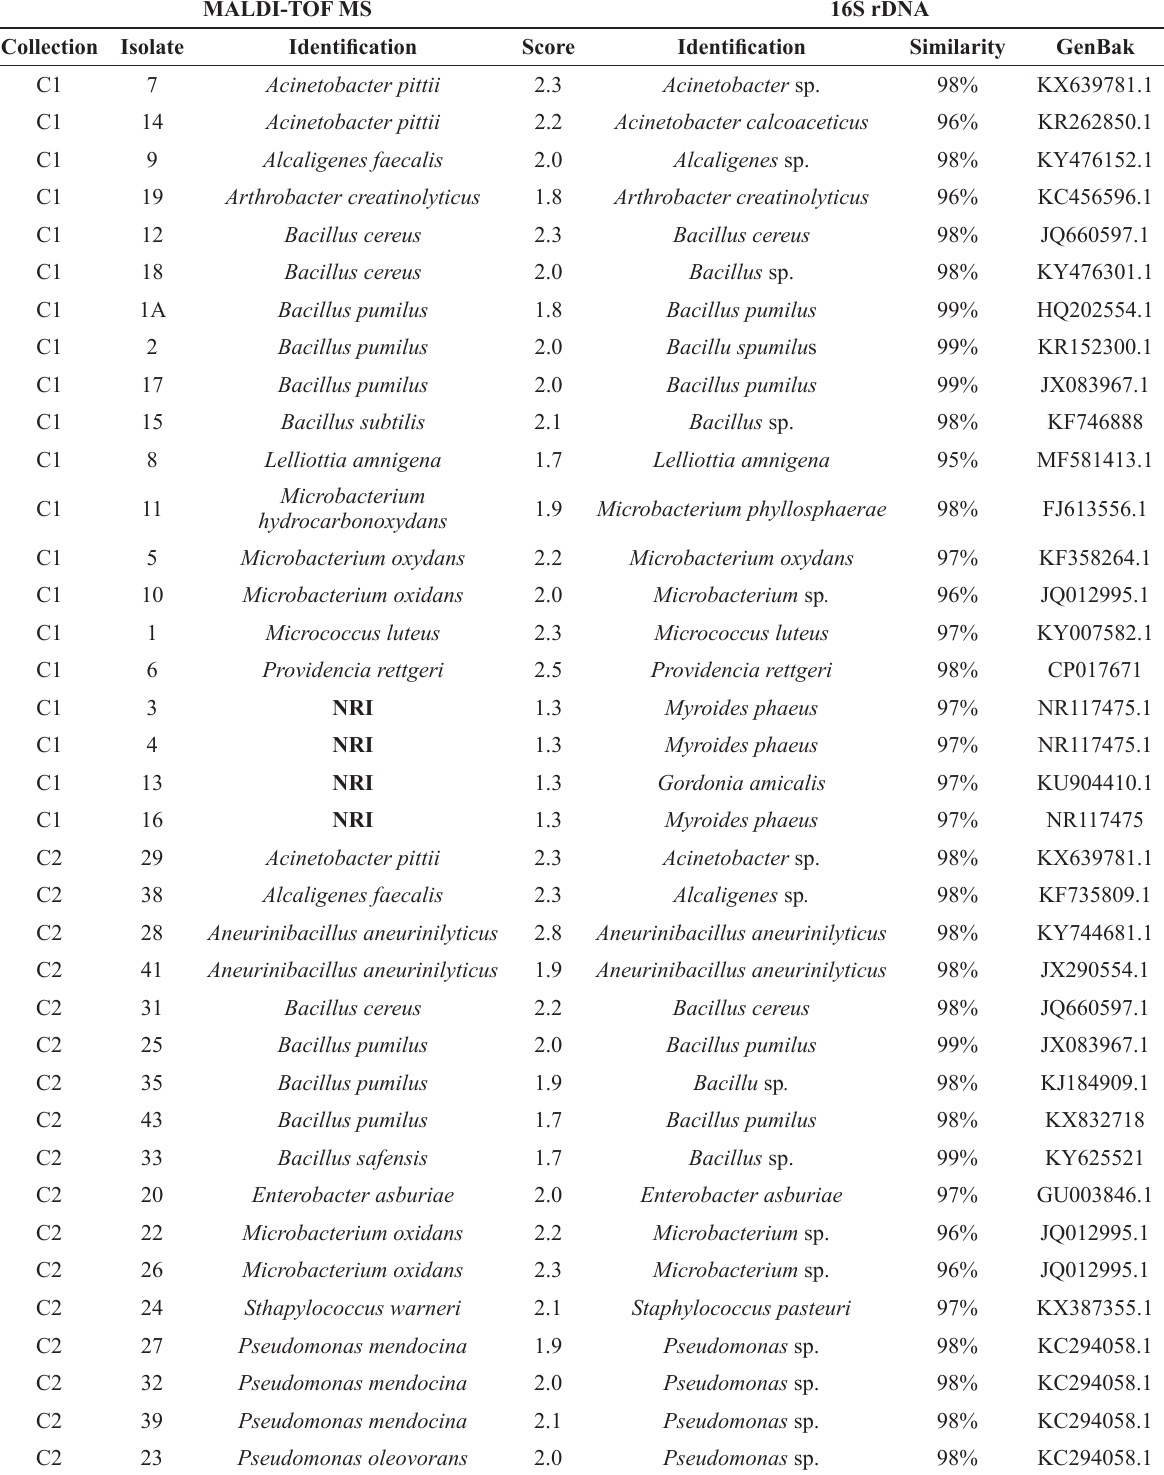
Isolates identification using MALDI-TOF MS and